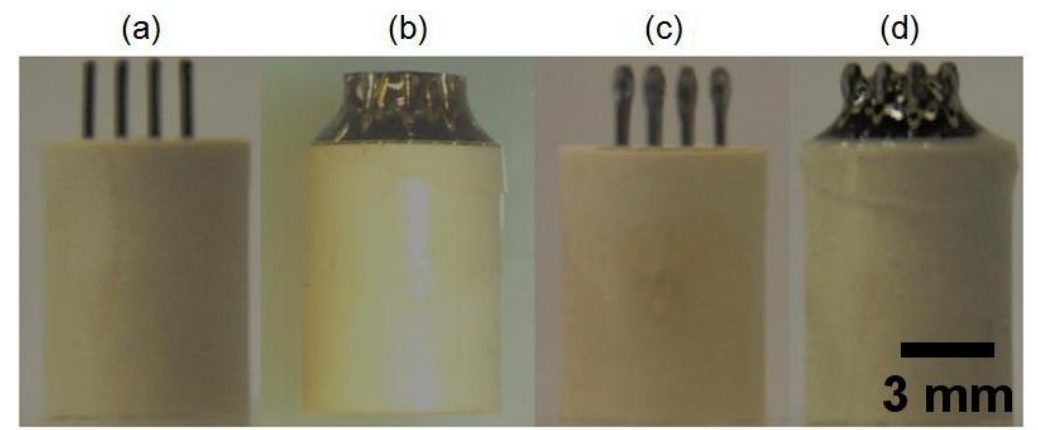
Figure 1. Insulation steps for array fabrication showing the array without insulation ( a ), one-step insulation ( b ), two-step insulation: tip insulation ( c ) and bottom insulation ( d